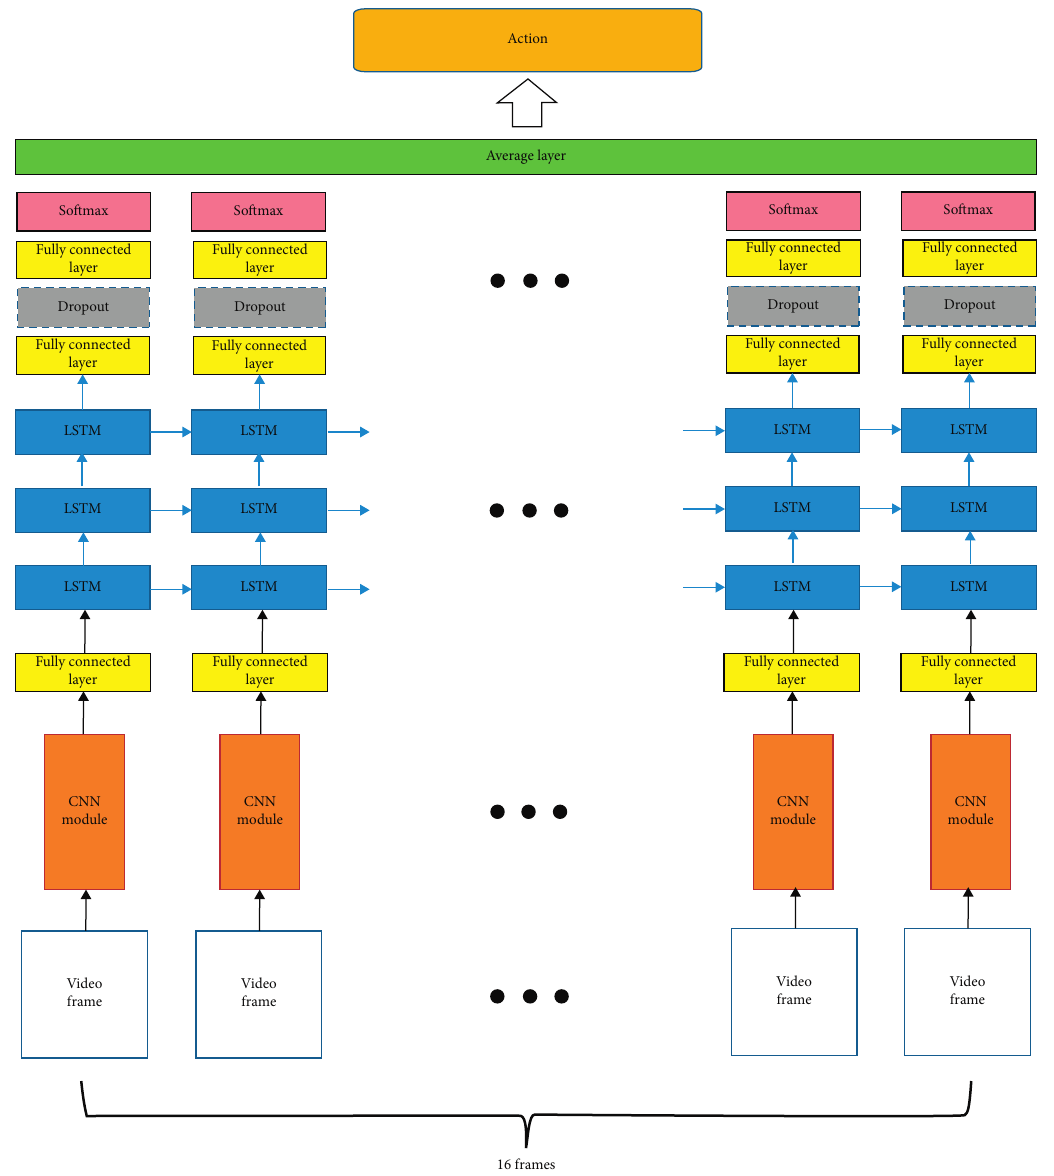
Figure 6: Structure of the simplified temporal convolutional network